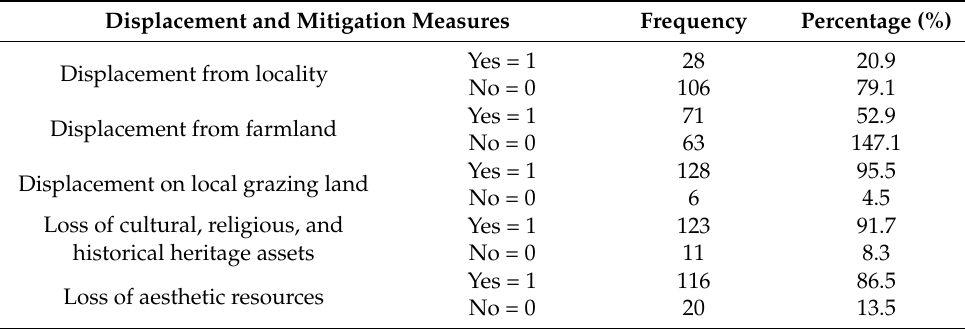
Table 4. Local people displacement due to the